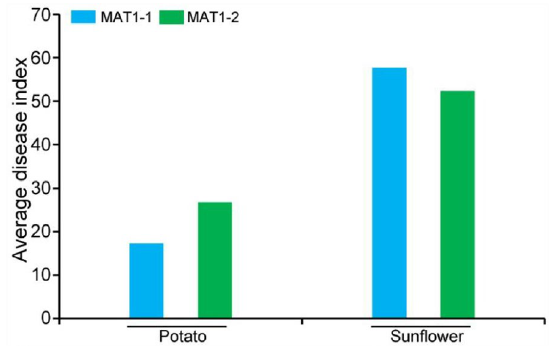
Figure 3. Average disease index of the 20 randomly selected V. dahliae isolates from potato and sunflower. MAT1-1 and MAT1-2 represent morphological mating types 1 and 2, respectively. The results were obtained 25 days post root dipping inoculation of host plants.